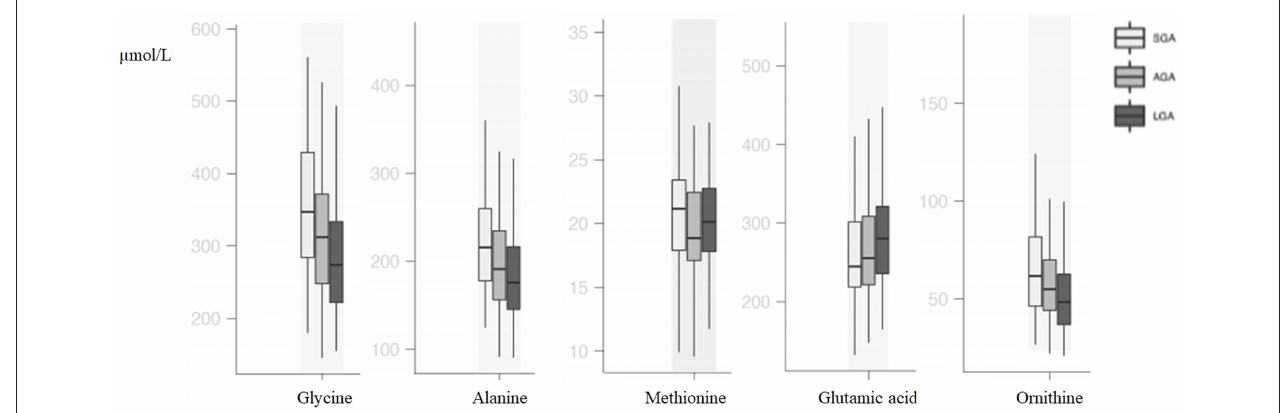
FIGURE 1 | Box and whisker plots of amino acids significantly different among groups.